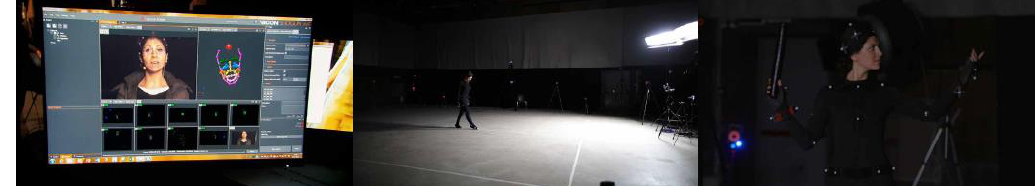
Figure 11. Sequence of images of the performance capture phases. Copyright © Digitalcomoedia.